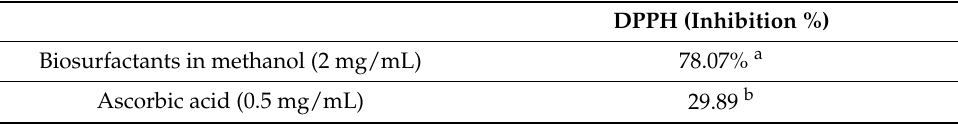
Table 5. The antioxidant activity of the biosurfactants secreted by Panthoea alhagi as compared to ascorbic acid (AA) expressed in percentage of inhibition of the free radical scavenging activity. DPPH (Inhibition %) Biosurfactants in methanol (2 mg/mL) 78.07% a Ascorbic acid (0.5 mg/mL) 29.89 b a,b Different subscript letters present significant difference at p <